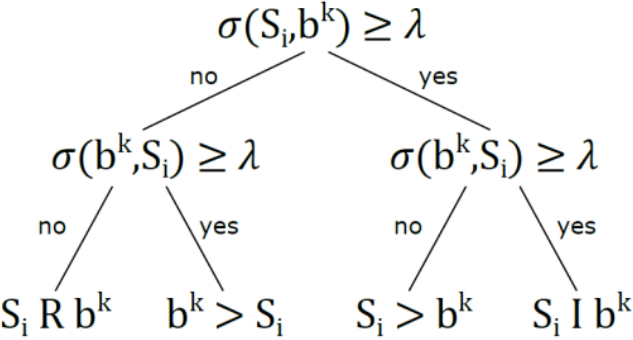
Figure 10. Construction flow-chart of the outranking